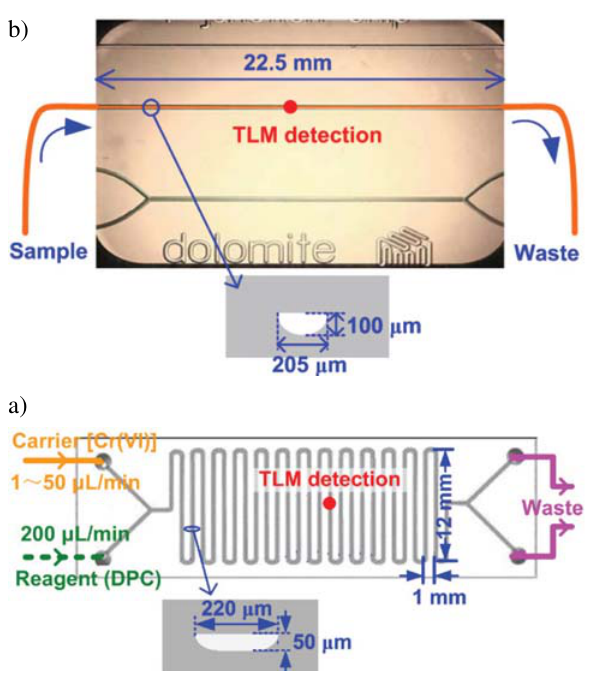
Figure 1. Schematic diagrams of (a) continuous flow analysis on microchip N1 and (b) microfluidic-FIA on microchip N2, with in- dicated TLM detection points. See the text for details.